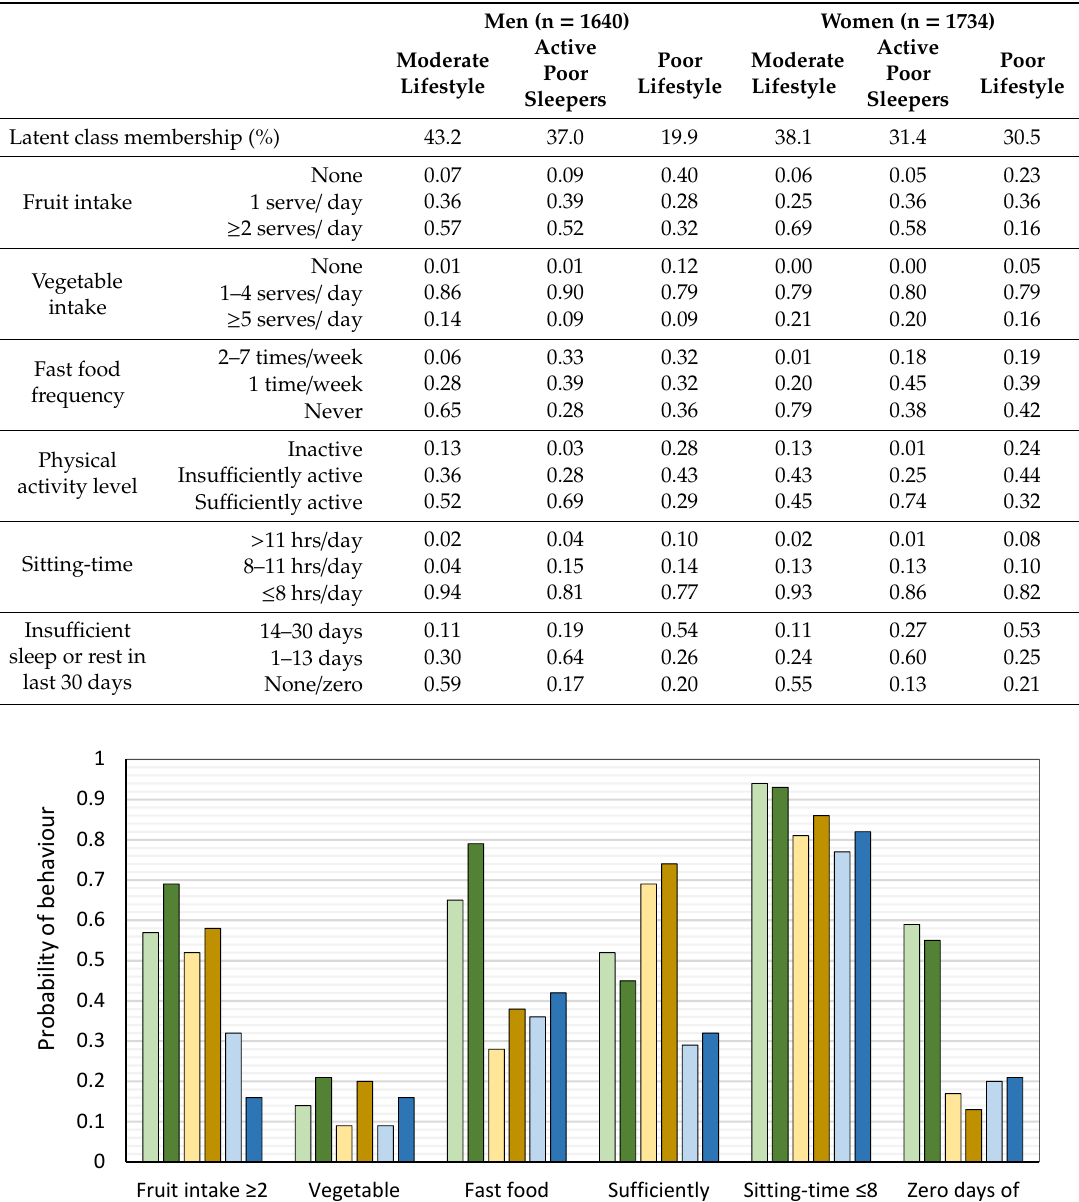
Table 2. Latent class analysis by sex, item-response probabilities for health behaviour indicators (n = 3374).